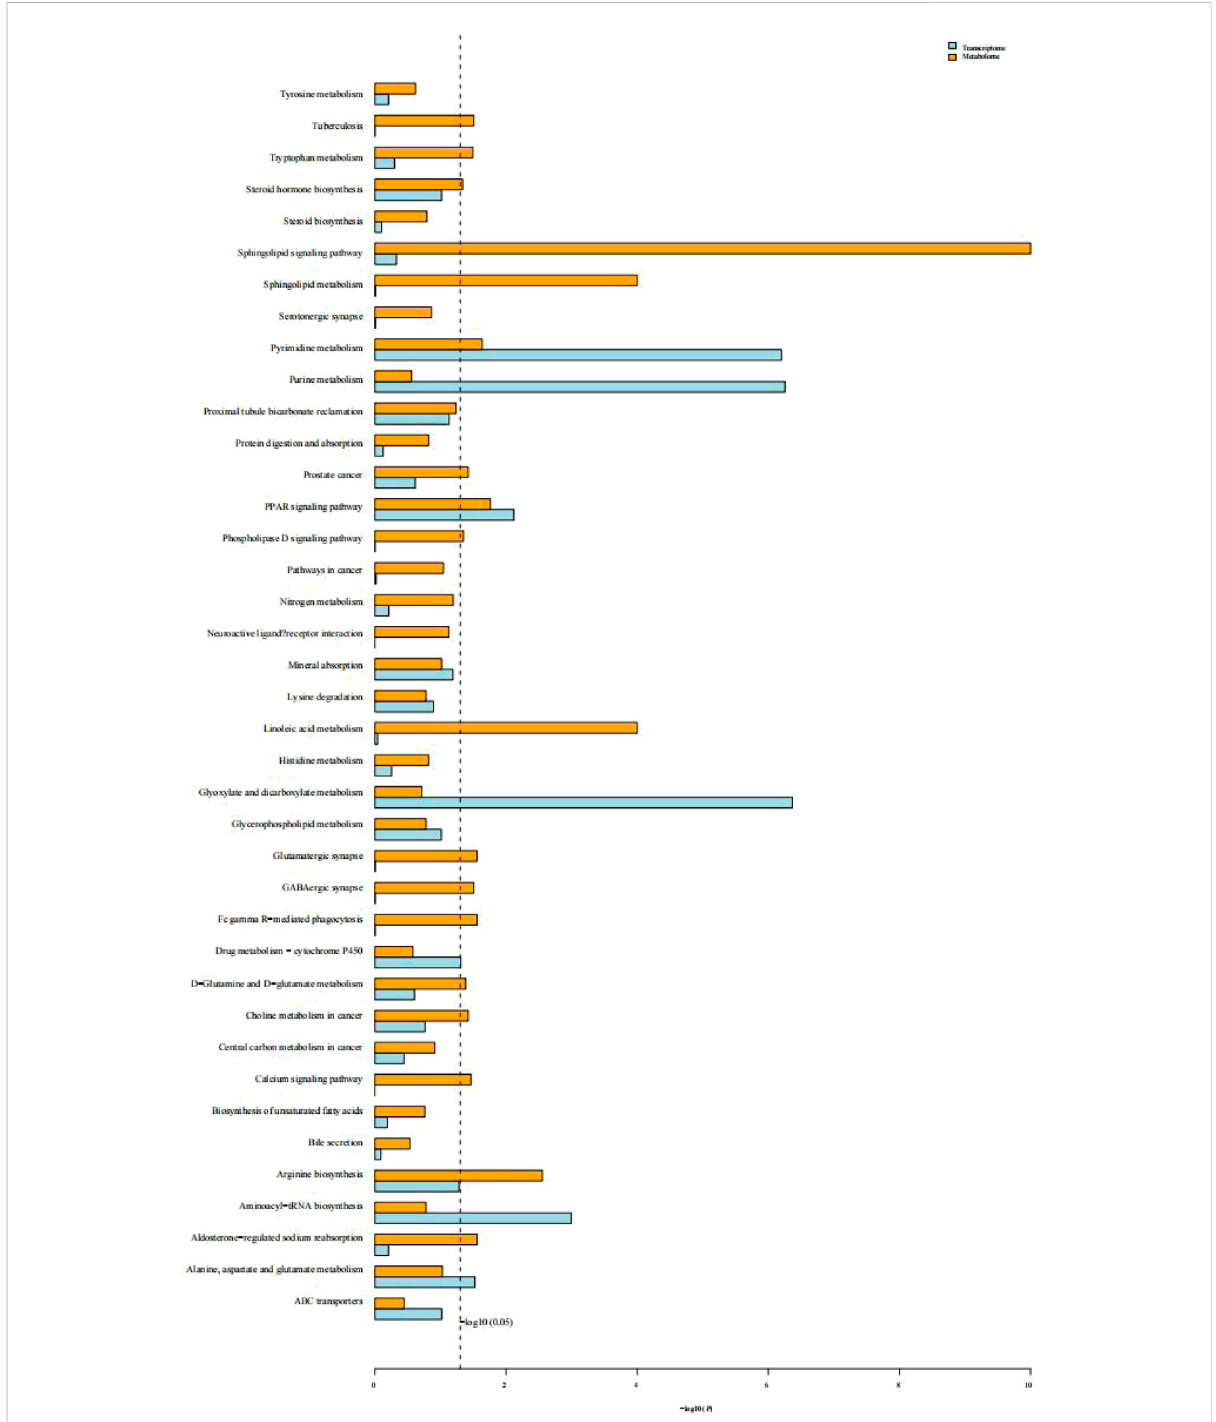
FIGURE 9 Histogram of the KEGG enrichment analysis of DEGs and differentially expressed metabolites. Blue depicts the transcriptome and yellow depicts the metabolome. The ordinate text indicates the pathway involved. The horizontal axis represents the signi fi cance of pathway enrichment, i.e., p-value and log P . The longer the column, the more signi fi cant the association of a biological pathway to the samples